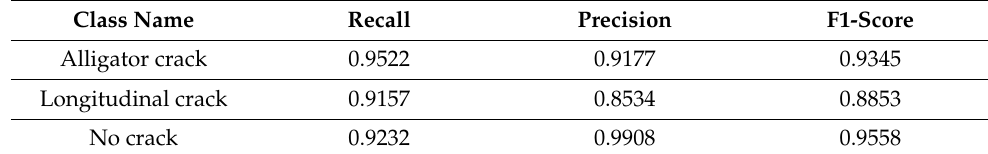
Table 4. Performance metrics for each class of CNN model.